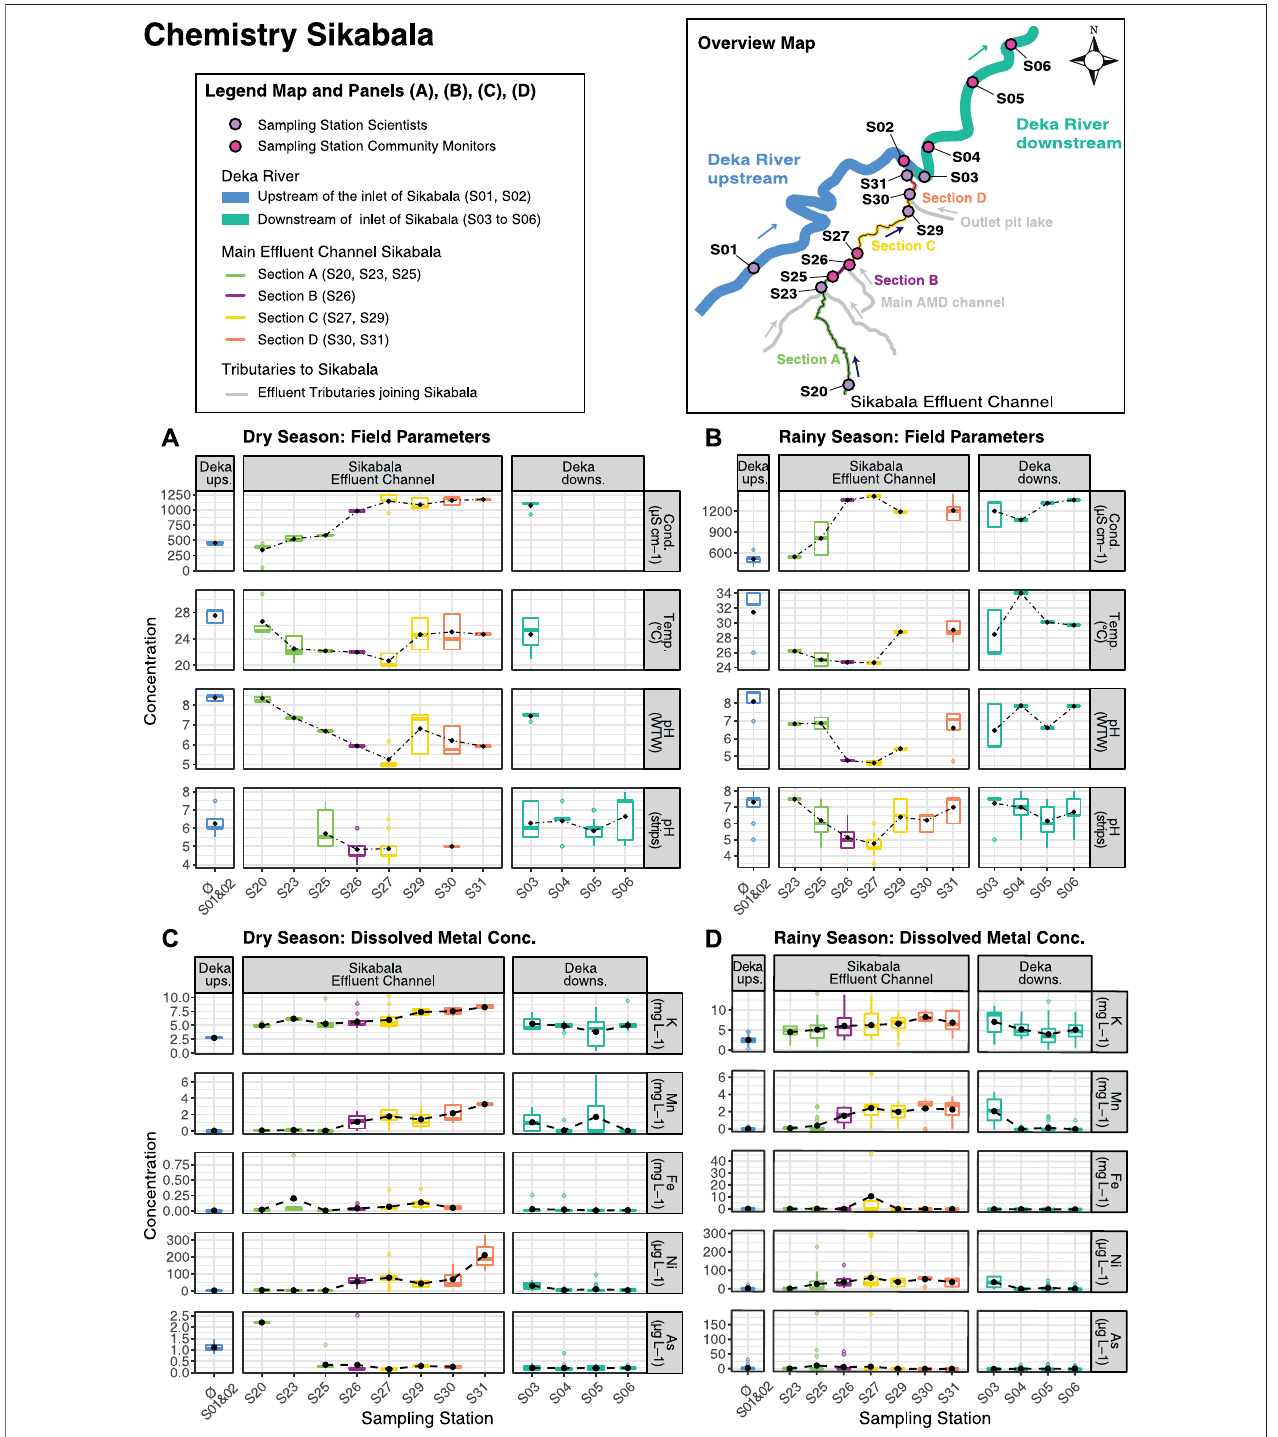
FIGURE 3 | (A,B) Boxplots of fi eld parameters in the dry and rainy season, respectively. (C,D) Boxplots of dissolved metal concentrations for the dry and rainy season, respectively. Water sampled between December 2018 and March 2020: 379 grab samples from community monitors, 173 triplicates from scientists ( fi lt./acid.; un fi lt./unacid.; fi lt./unacid.). Black dots represent average values and dashed lines show trend between them. In each panel, the fi rst and last facet show data in Deka River up- and downstream of the inlet of ef fl uent channel Sikabala, respectively. The middle facet shows data of sampling stations within Sikabala. Color code relatestothedifferentsectionsinSikabala.ConcentrationsofDekaRiverupstreamaredepictedforcomparisonbyaveragingthedatameasuredatsamplingpointsS01 and S02 (Ø S01 & 02). Scale of Y-axis varies between dry (A,C) and rainy season (B,D) .